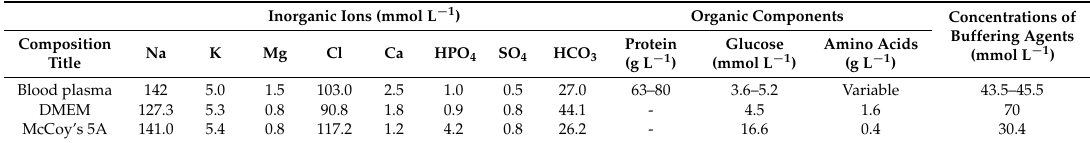
Figure 5. Corrosion rates of pure Zn and Zn-4Ag in DMEM and McCoy’s 5A calculated from released Zn ions. Table 2. Composition of the blood plasma, DMEM and McCoy’s 5A